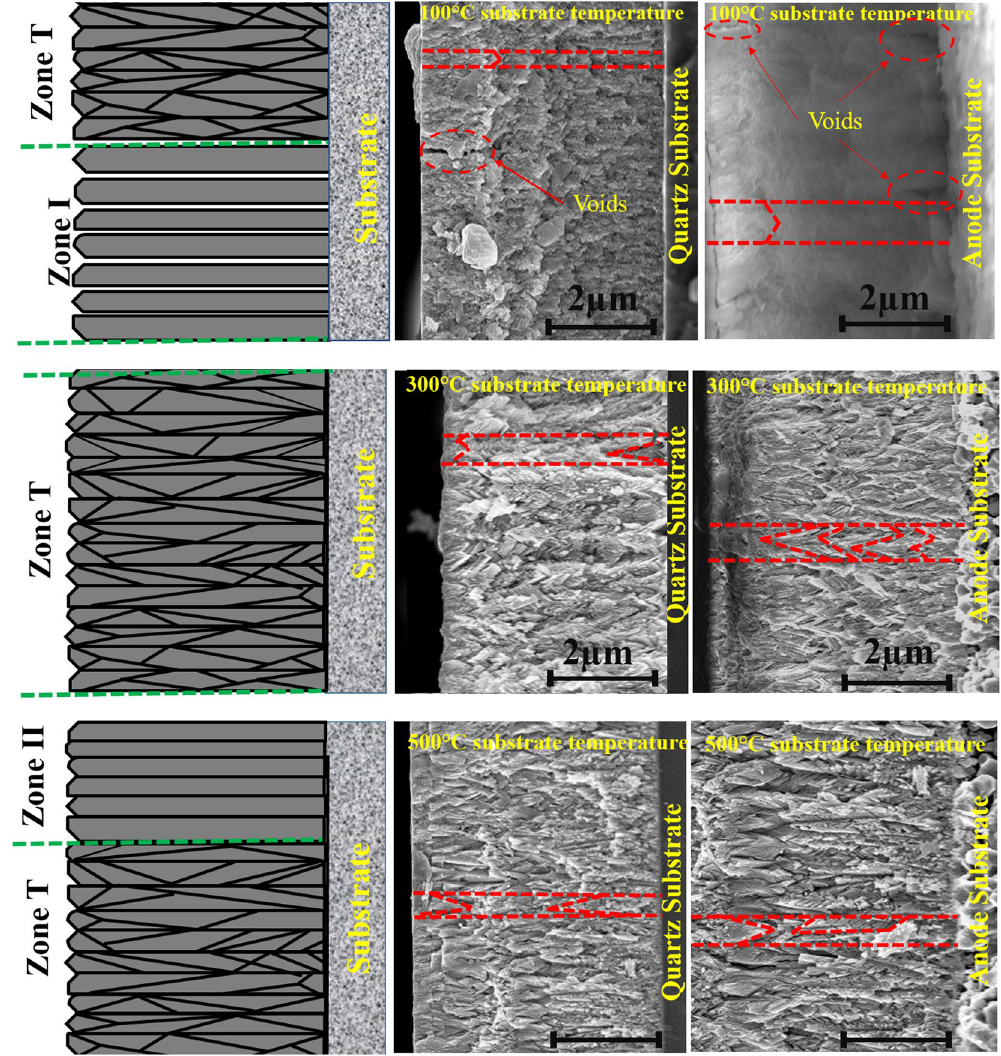
Figure 9. Cross-sectional view of a thin film deposited at 100, 300 and 500 °C substrate temperature correlated with the ESZM